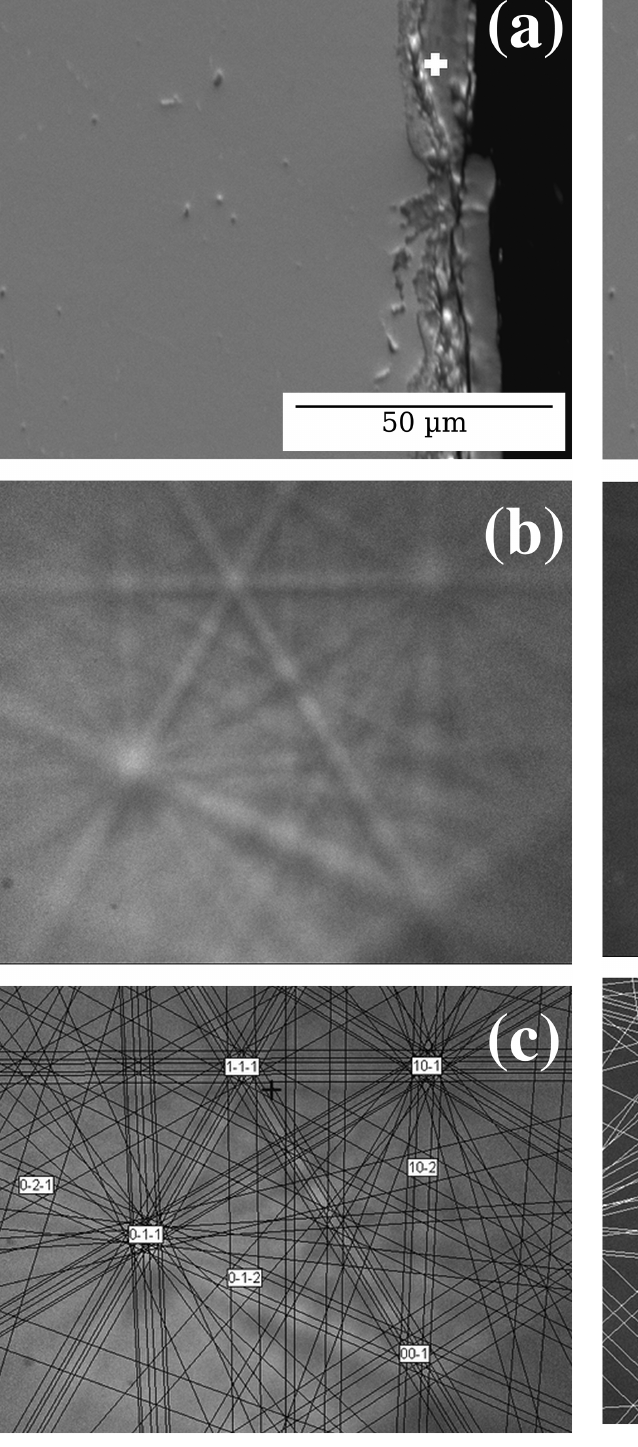
Figure 8: The results of EBSD analysis of the central part of the oxide scale growing on the surface of the X2CrNiMo17-12-2 steel sample: (a) cross-section of oxidized steel sample with marked micro-region, in which the EBSD analysis has been performed (b) an electron backscatter diffraction pattern (c) results of simulation of indexed planes for crystalline FeCr 2 O 4 .